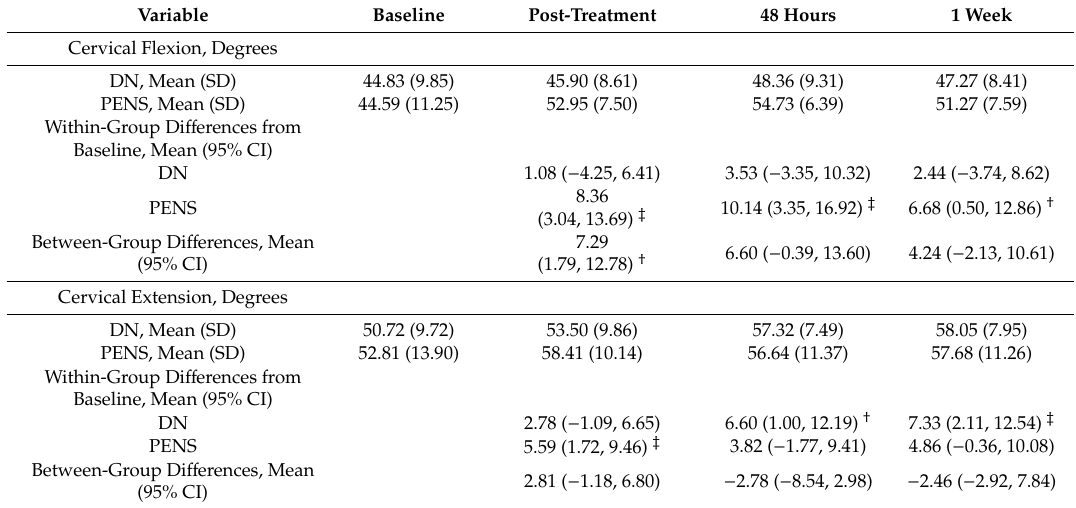
Table 4. Cervical flexion and extension range of movement di ff erences within- and between-group. Variable